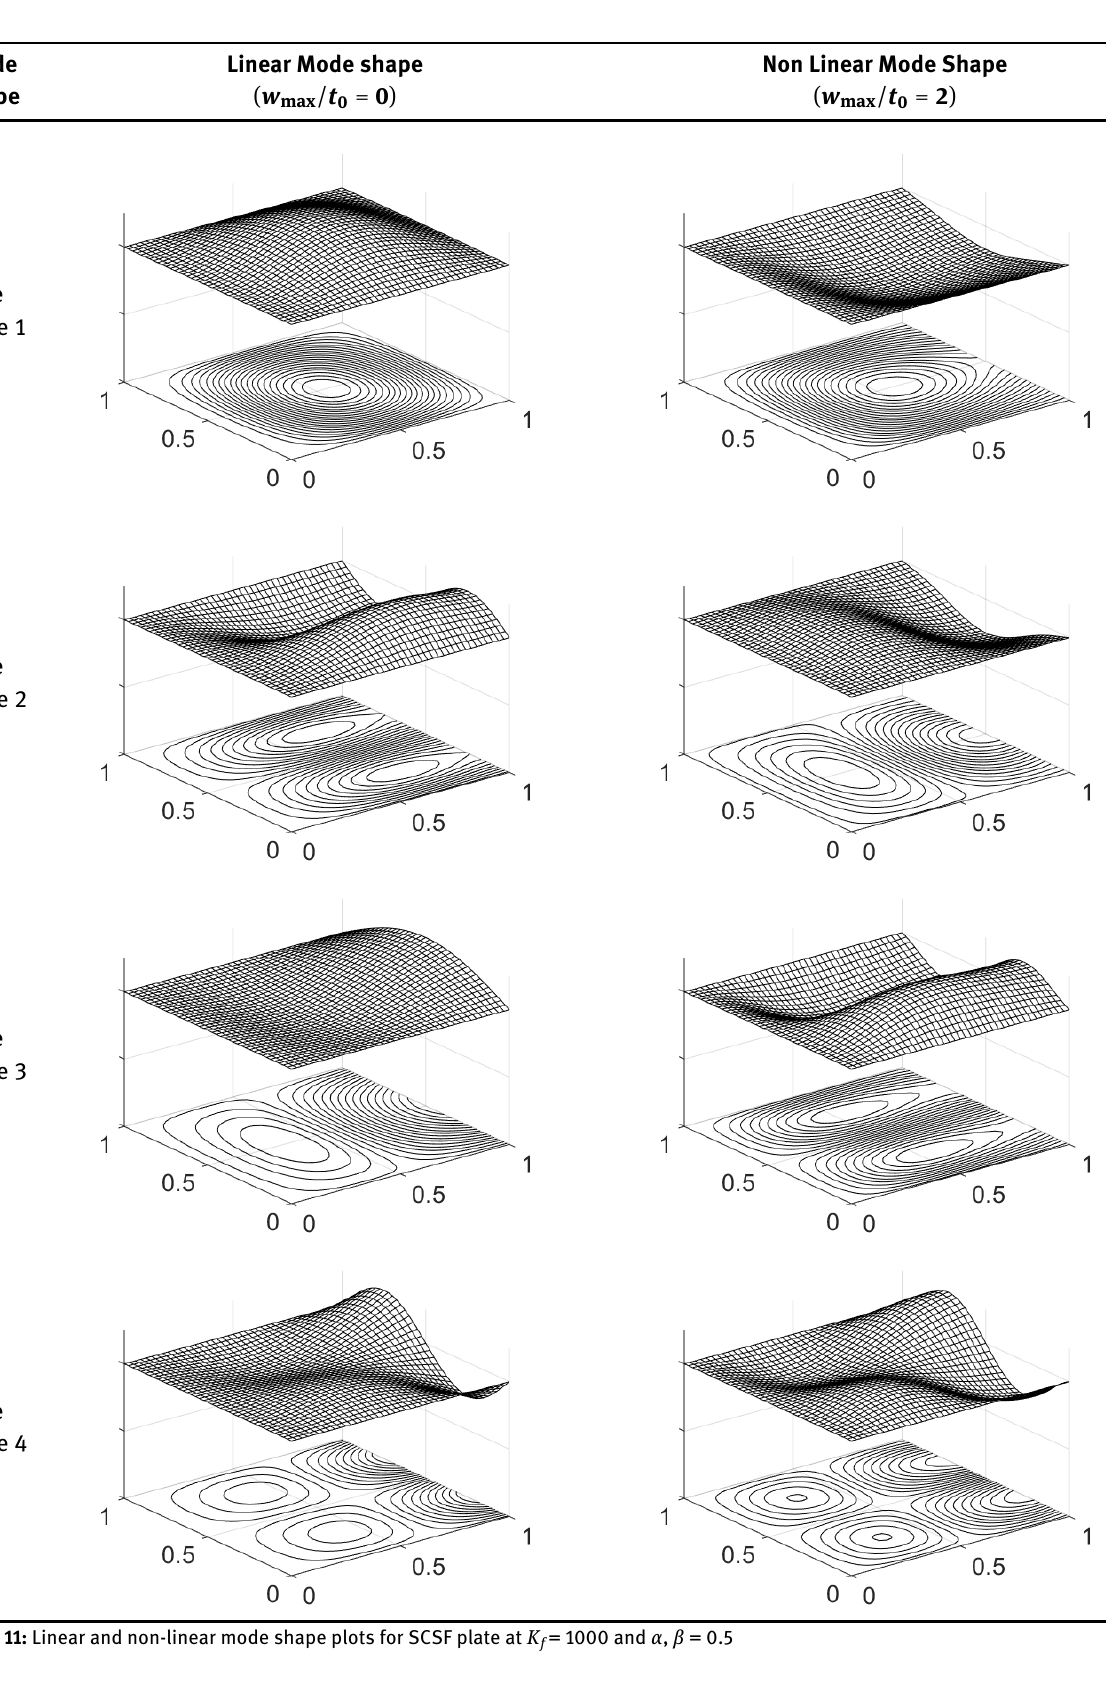
Figure 11: Linear and non-linear mode shape plots for SCSF plate at K f = 1000 and α , β =